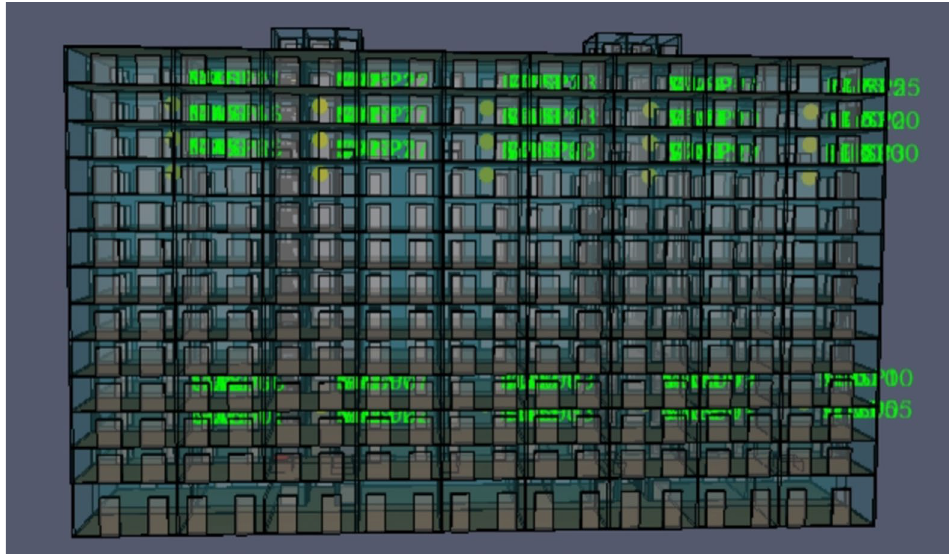
Figure 5. Sensor relative position diagram (the circle marks the location of the fire